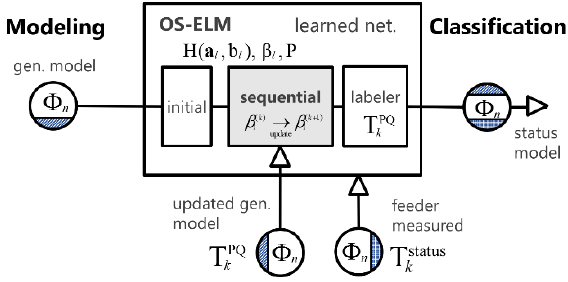
Figure 5. Classification network diagram considering learning data sequences.